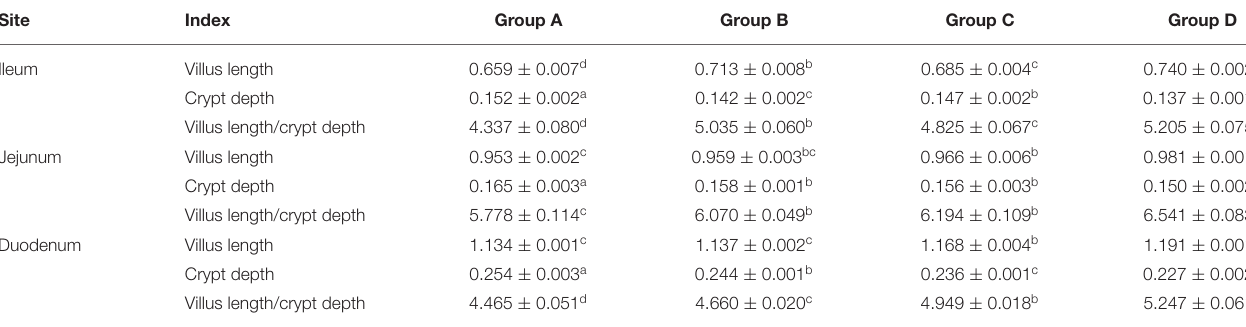
TABLE 7 | Villus length, crypt depth and villus length/crypt depth of 21-day-old yellow -feathered chickens in different treatment groups.